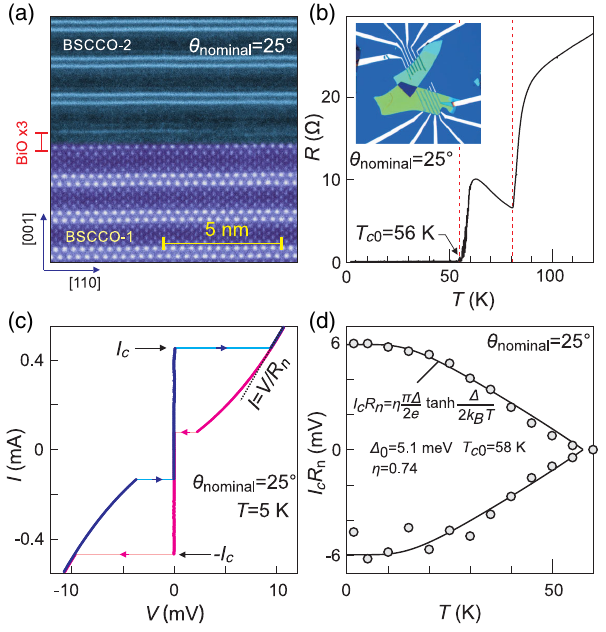
FIG. 4. Data of a BSCCO-BSCCO junction with a nominal twist angle of 25°. (a) High-resolution transmission electron microscope image of the junction region taken after the low- temperature transport measurements. (b) Temperature-depen- dent resistance across the junction. The first drop around 80 K stems from the superconducting transition of the individual BSCCO flakes. The second drop around 56 K is the super- conducting transition in the artificial junction. Inset shows an optical image of the sample. (c) Tunneling I - V characteristic measured across the artificial junction. Blue and pink colors represent the positive and negative sweep directions, respec- tively. (d) I c R n as a function of temperature for both the positive and negative biases. Solid curves are fits to a modified Ambegaokar-Baratoff formula (shown in the inset). The fitting parameters are listed in the